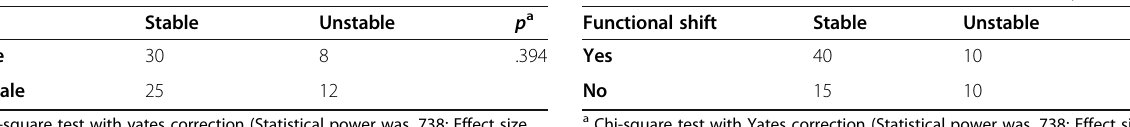
Table 1 Cross tabulations of difference in sex and chi-square test